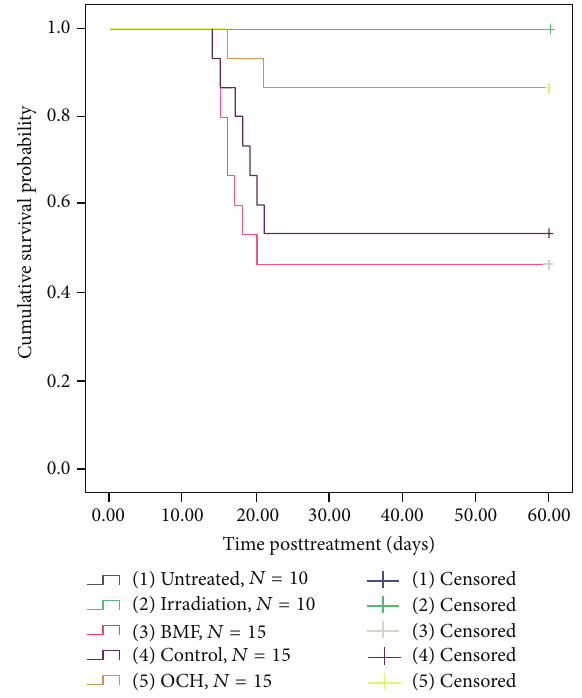
Figure 2: Kaplan-Meier analysis of overall survival in mice from different